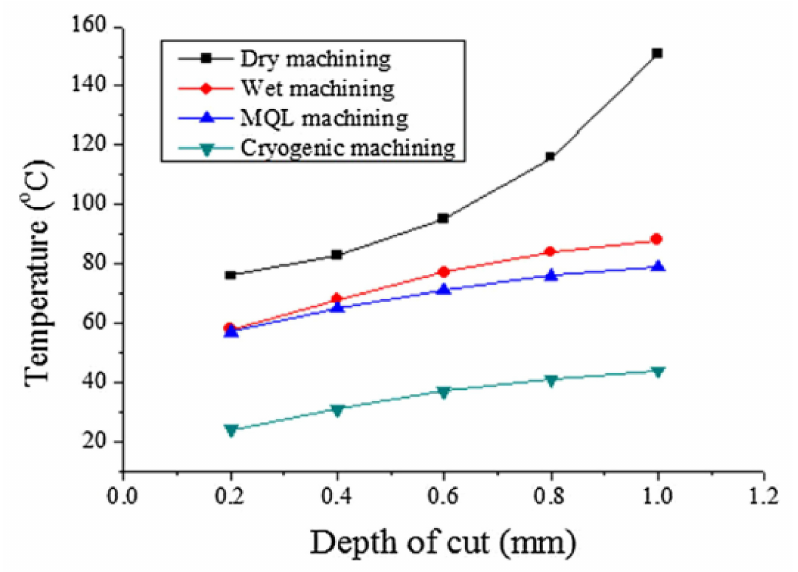
Figure 16. Effect of DOC on cutting temperature under different cooling techniques, reprinted with permission from ref. [78]. Copyright 2018